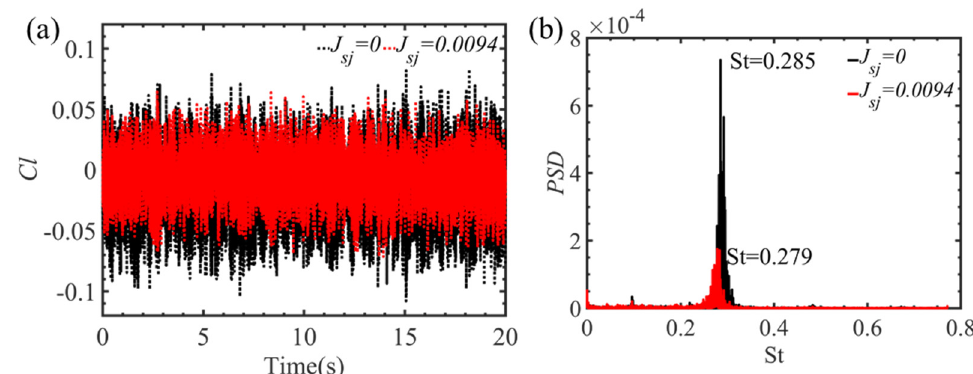
Figure 6. Time histories ( a ) and power spectrum analysis ( b ) of the lift force being exerted in the SBG model of cases J sj = 0 and J sj = 0.0094.